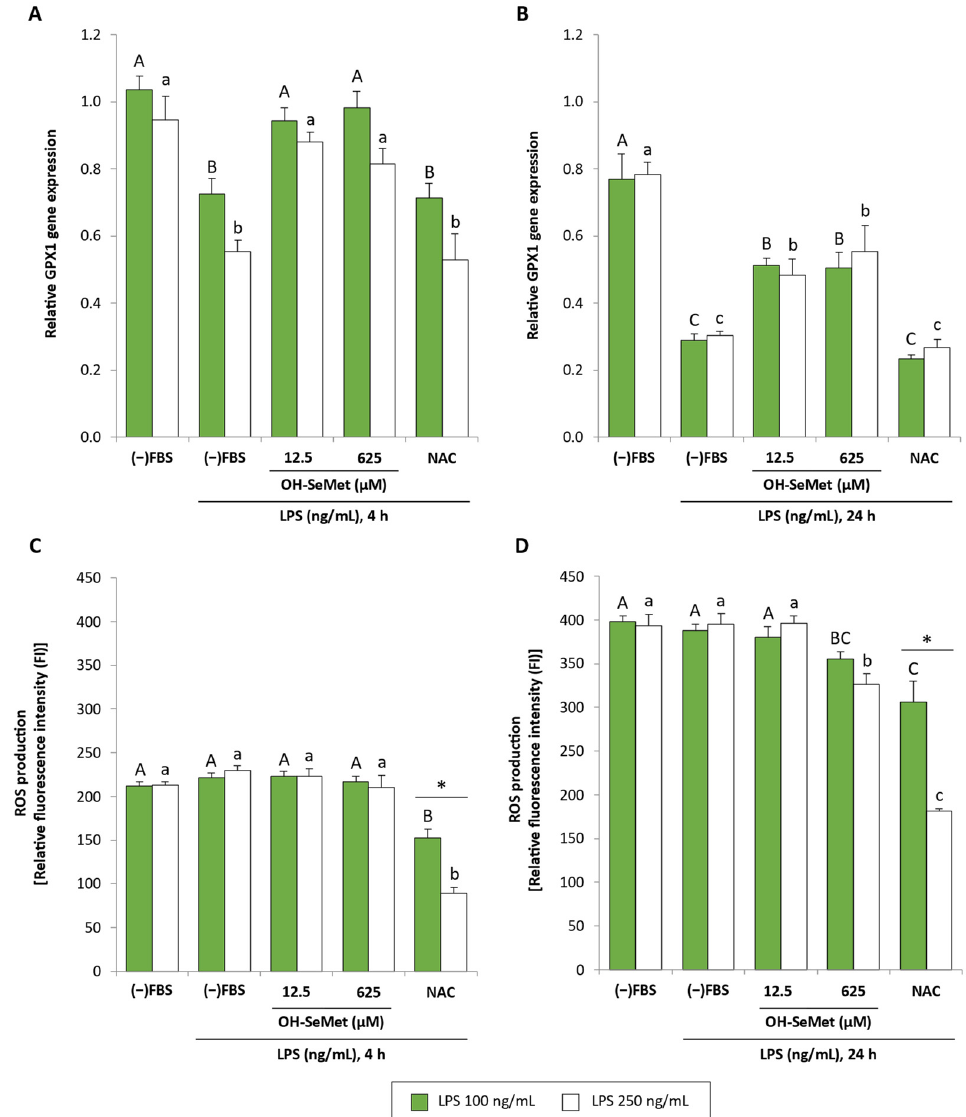
Figure 5. GPX1 relative gene expression ( A , B ) and ROS production ( C , D ) in macrophages maintained in ( − )FBS for 24 h, supplemented for 24 h with 12.5 and 625 μ M OH-SeMet or 10 mM NAC and then stimulated with LPS (100 and 250 ng/mL) for 4 or 24 h ( A – D , respectively). Gene expression results were calculated using 2 −Δ Ct . ROS production results are shown as relative fluorescence intensity (FI) obtained at the beginning of the experiment ((FI f × 100)/FI i ). The results are expressed as mean ± SEM of n = 6–9 cultures. The asterisk (*) denotes significant differences ( p < 0.05) between the two LPS concentrations used for each incubation period. Different letters denote significant differences ( p < 0.05) between conditions for each LPS concentration.